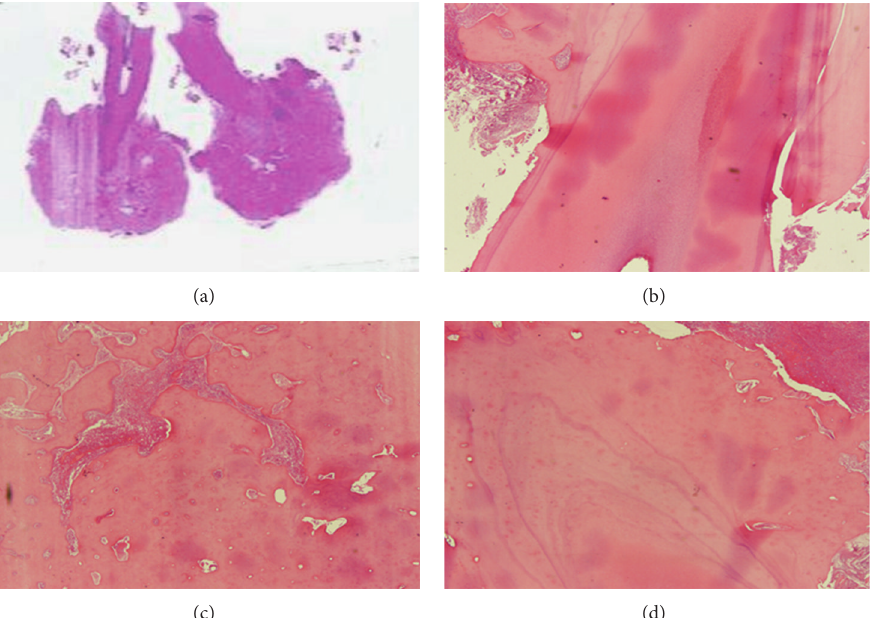
Figure 5: ((a) and (b)) H&E (4x \ 10x) cementoblastoma closely connected with the tooth root; ((c) and (d)) H&E 20x. Cementoblastoma and residual cementoblastoma revealed the same histological appearance: dense mineralized acellular trabeculae of basophilic tissue cement-like, devoid of vessels, adhering to the root of the